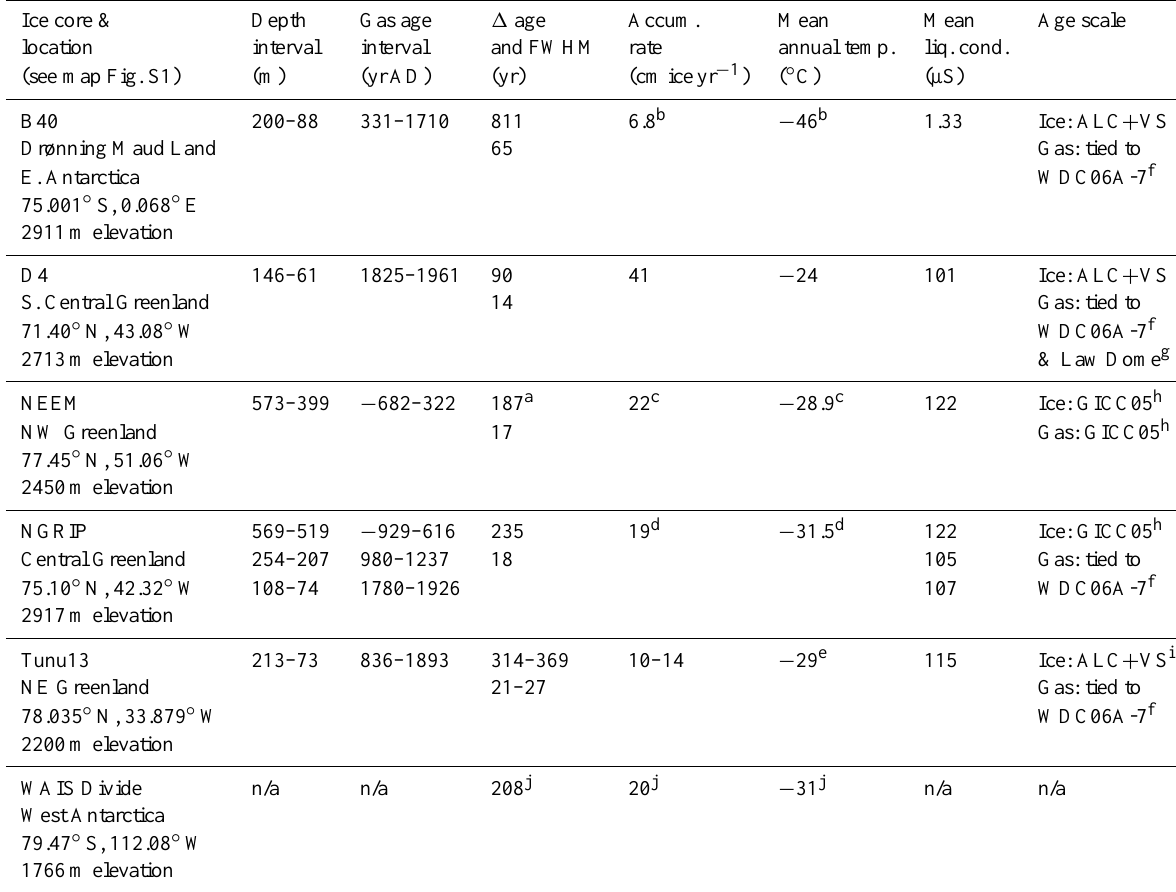
Table 1. Locations, site characteristics and other relevant information for ice cores featured in this study. Please refer to footnotes for explanation of